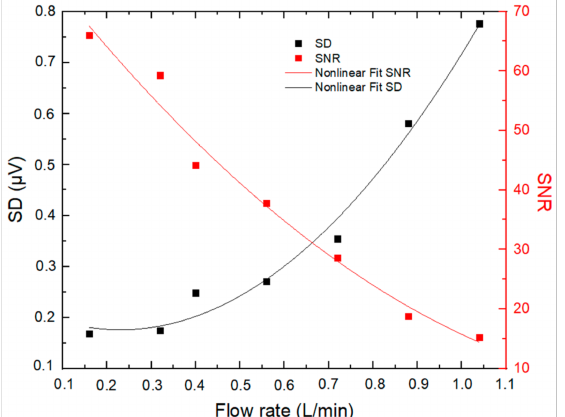
Figure 4. Dependence of the PA noise (Standard Deviation—SD of 1 s blank measurements) and SNR of the PA signal on the sampling flow rate.